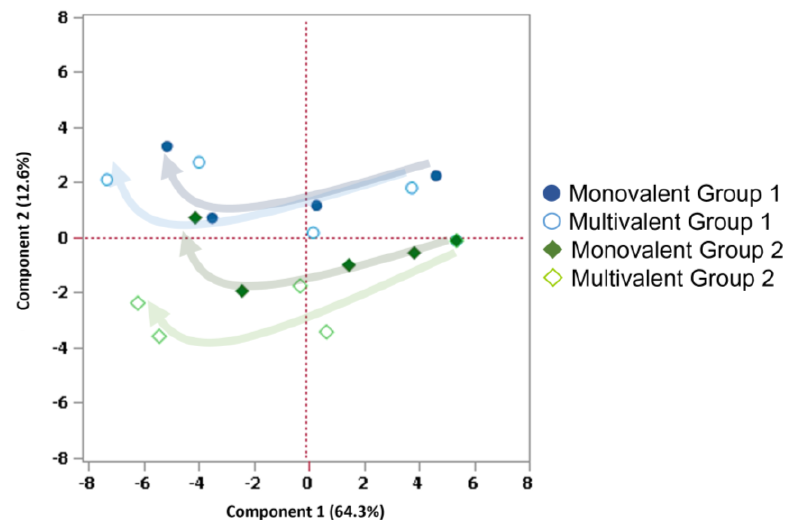
Figure 4. Principal component analysis (PCA) of metabolites and bioprocess-related parameters’ concentrations/values assessed throughout the infection phase for the four HA-VLP production runs at WAVE 20 L bioreactor scale. Color code: Monovalent Group 1 (dark blue), Multivalent Group 1 (light blue), Monovalent Group 2 (dark green), Multivalent Group 2 (light green). Arrows indicate the separation trend over the course of